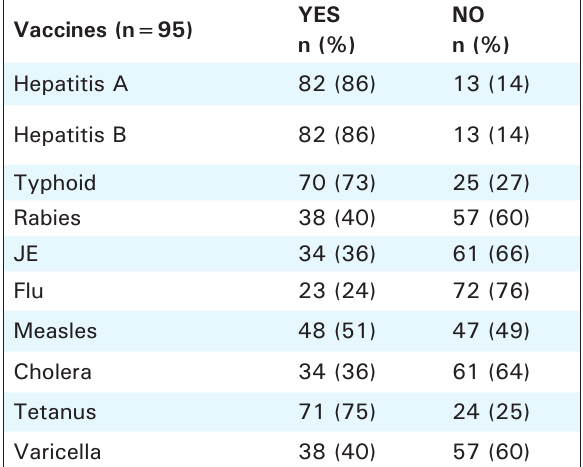
Table 1. Percentage of traveller immunized against different